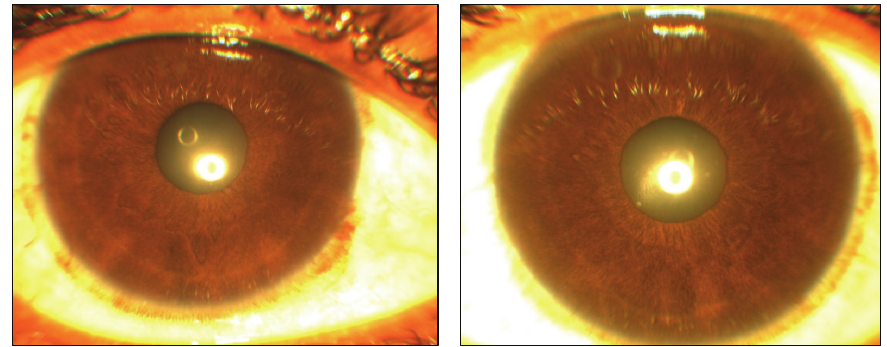
Figure 1: Anterior segment photograph showing subtle iris heterochromia (hypochromic right eye on the left side).